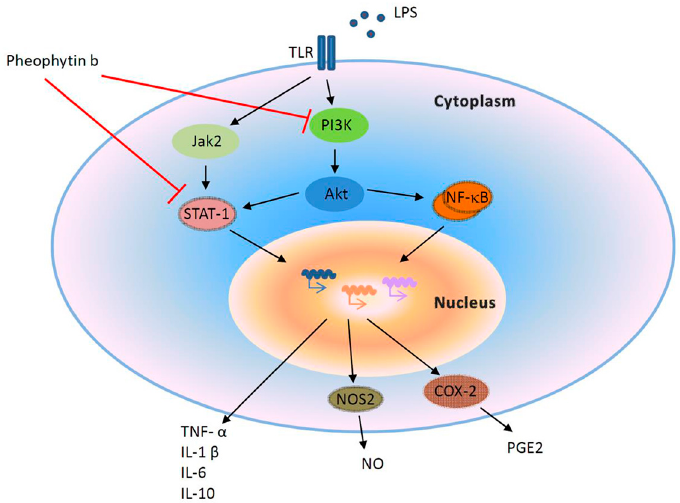
Figure 8. Proposed mechanism depicting the effect of pheophytin-b on LPS-stimulated macrophages. Production of NO, PGE2, IL-1 β , IL-6, IL-10, and TNF- α induced by LPS are suppressed by pheophytin-b inhibition of STAT-1 and PI3K/Akt signaling pathways.